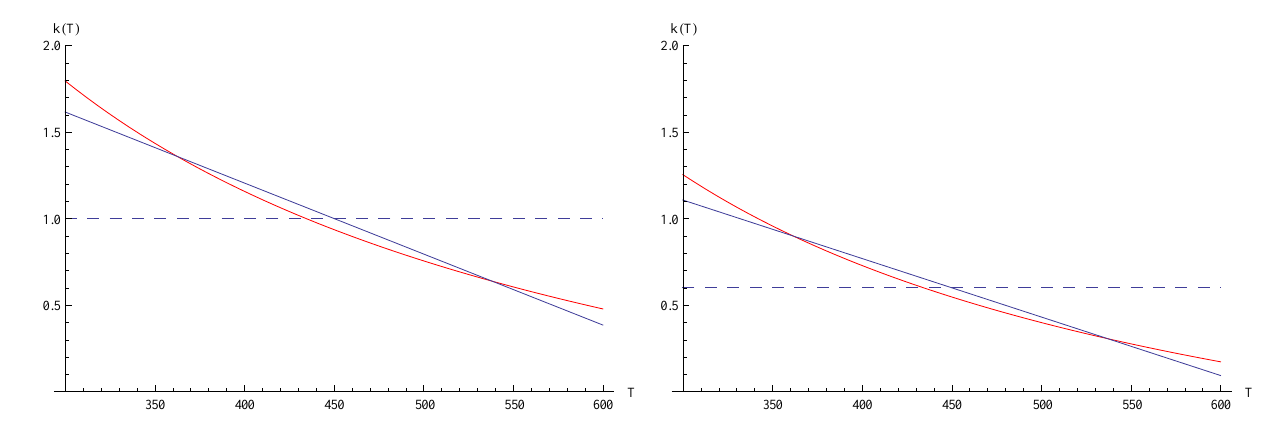
( T ) (red) compared with the best straight line k ( T, ξ Figure 5. Optimal functions k max derived from Figure 1. left: (blue) from Figure 2 plotted with the optimal parameter ξ opt ξ = 4 . 2 for k = 1 ; right: ξ = 11 . 9 for k = 0 . 6 . opt o opt o